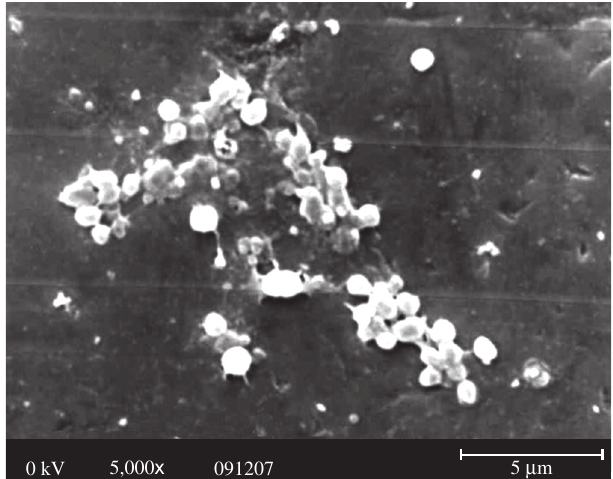
Figure 2. SEM of CP Ti polished surface showing the attachment and forma- tion of S. mutans biofilm.